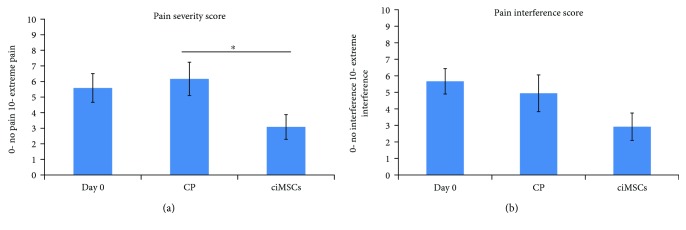
Mean scores (±standard error of the mean) of the pain severity score (PSS) and pain interference score (PIS) at baseline (day 0), after placebo control product (CP) administration (week 6) and after xenogeneic chondrogenic induced mesenchymal stem cell (ciMSC) administration (week 12). The asterisk (∗) indicates a significant difference in mean scores between the two treatment groups (P < 0.05).